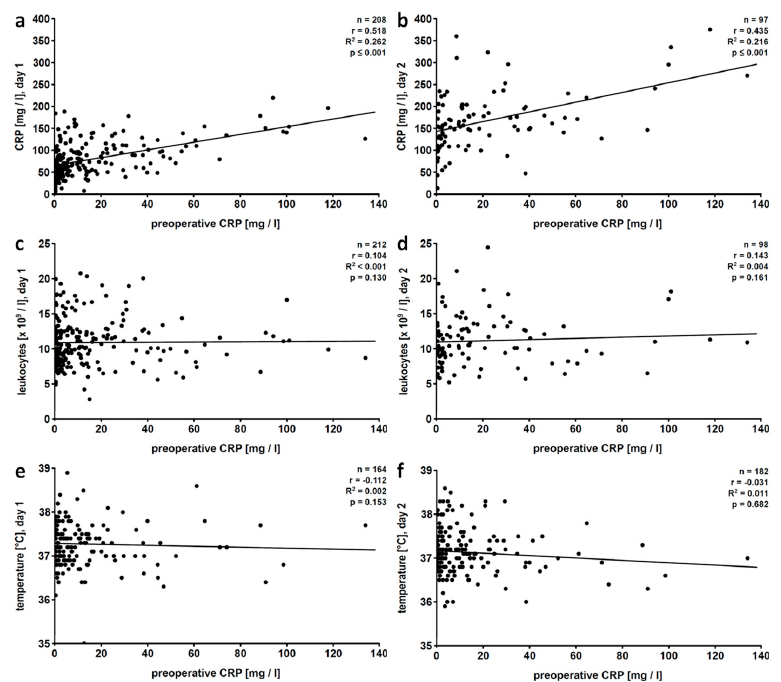
Figure 2. Total patient population: linear regression analyses of preoperative levels of C-reactive protein (CRP) with postoperative CRP levels ( a , b ), blood leukocyte counts ( c , d ) or fever ( e , f ).